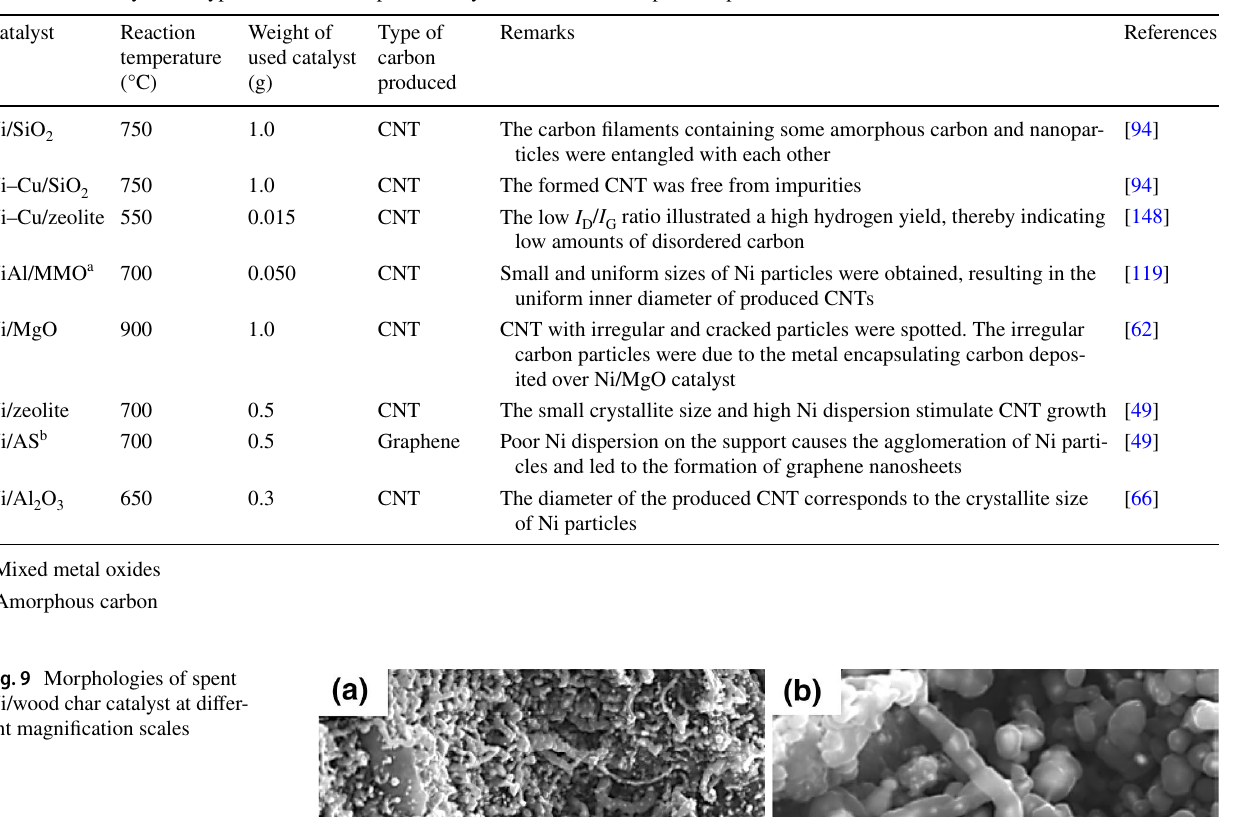
Table 2 Summary of the type of solid carbon produced by the methane decomposition process